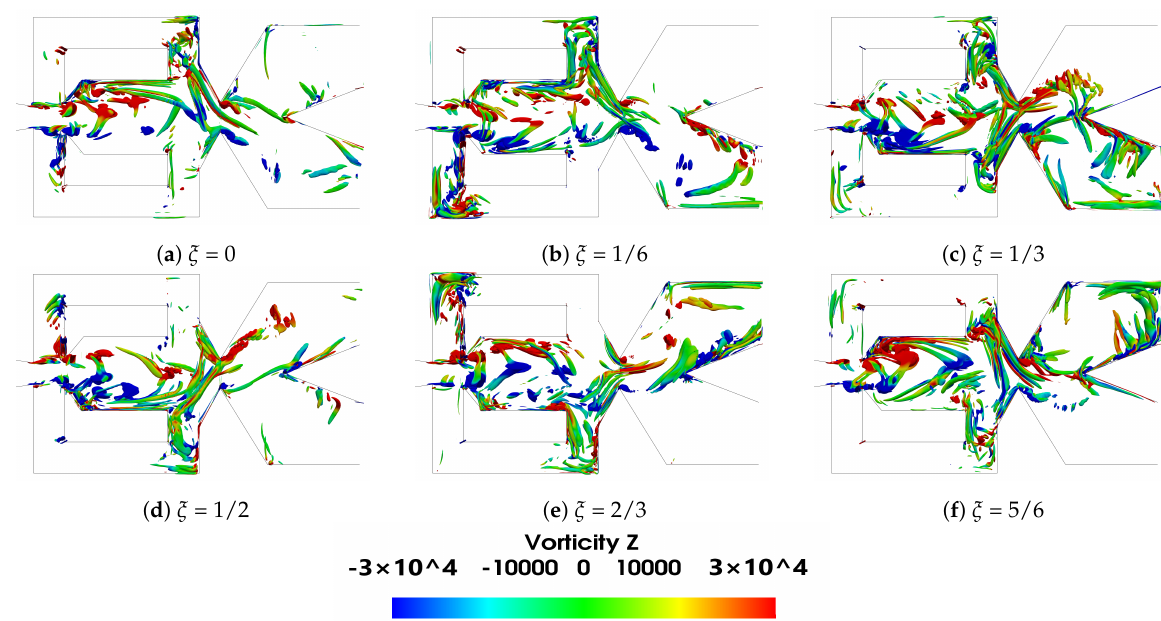
Figure 4. Q criterion representation at the mixing chamber period of oscillation divided into six equally spaced times, power nozzle velocity 65 m/s. Q = 5 × 10 8 . Baseline case.